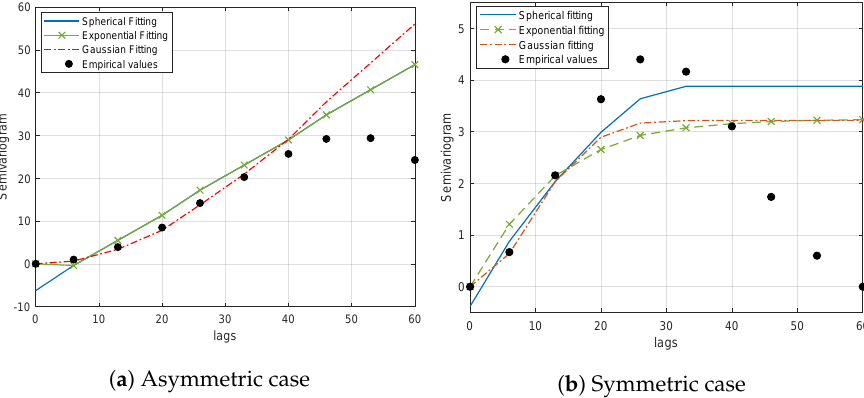
Figure 3. Example of spherical, exponential and Gaussian semivariogram modeling fitting versus empirical